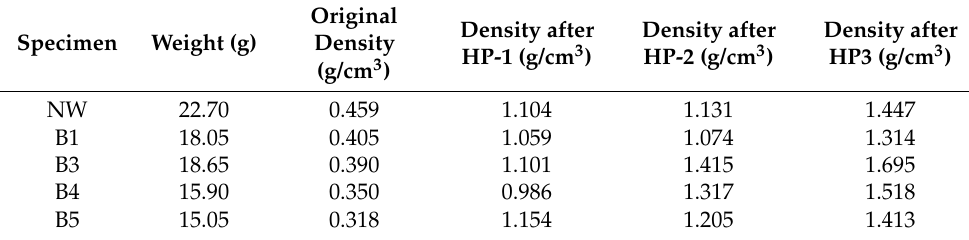
Table 2. Density changes of specimens under various bleaching steps and hot-pressing conditions.